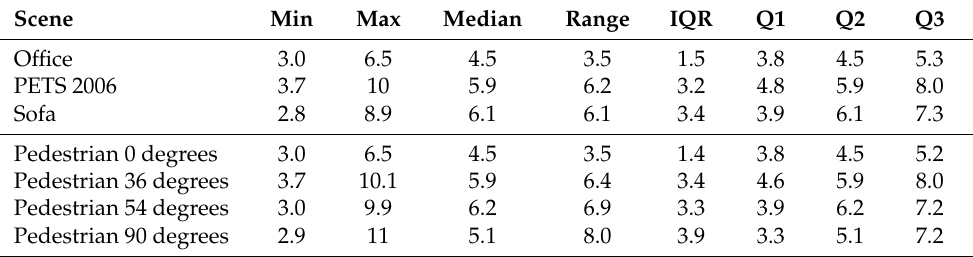
Table 1. Summary of the main characteristics of data shown in the box-plot diagrams of Figures 12 and